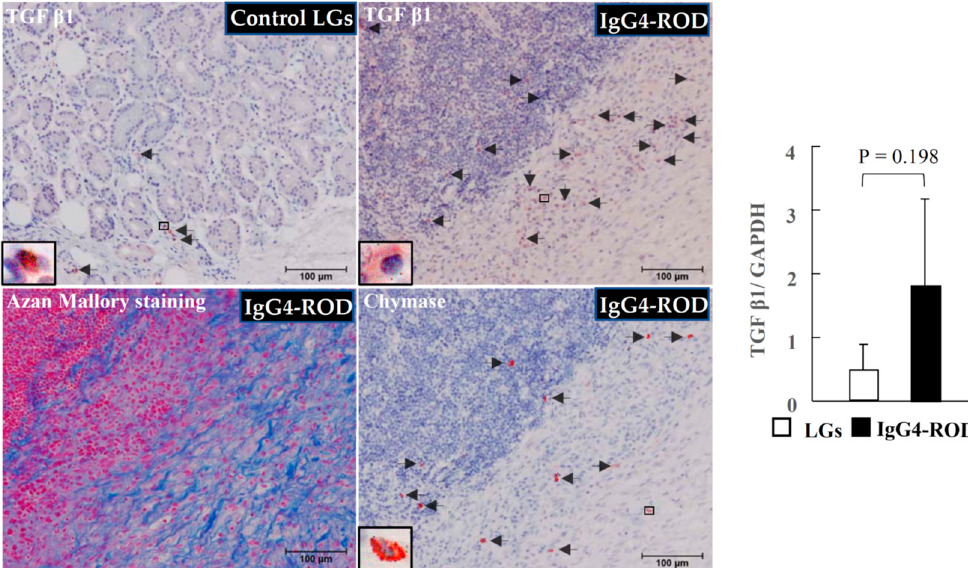
Figure 6. Representative images of transforming growth factor beta-1 (TGF- β 1) immunostaining of the normal control LGs, and representative images of TGF- β 1 and chymase immunostaining, as well as Azan Mallory staining, performed on serial sections of the LGs obtained from the IgG4-ROD patients. Black arrows indicate the TGF- β 1-positive cells or the chymase-positive cells. Bar graphs show the gene expression of TGF- β 1 in the LGs in two groups.